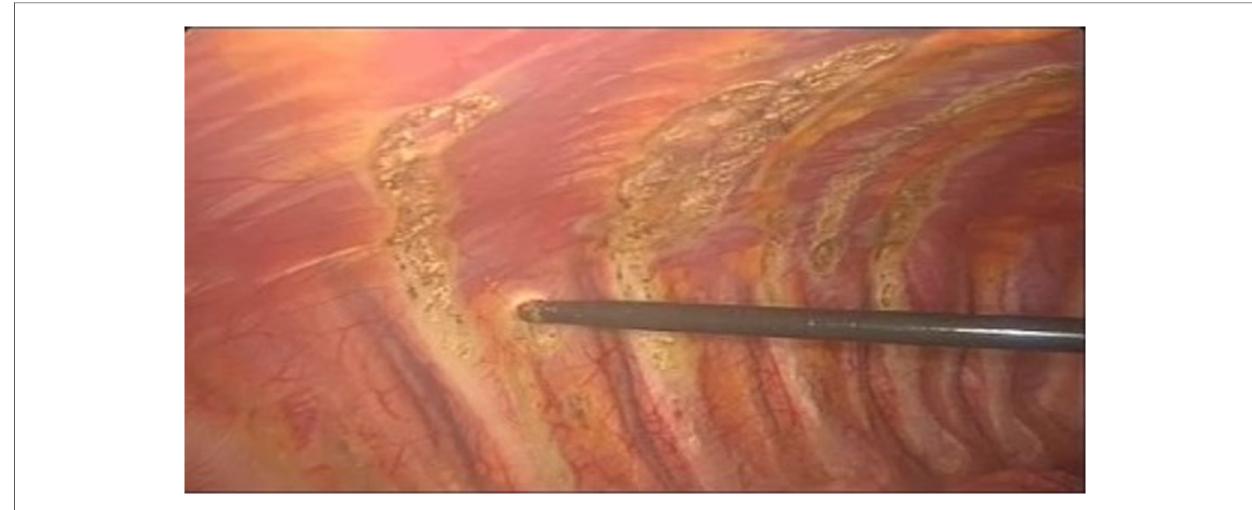
FIGURE 6 VATS mechanical pleurodesis with electrocautery on the parietal pleura to minimize the risk of CP recurrence. VATS, video-assisted thoracic surgery; CP, catamenial pneumothorax.